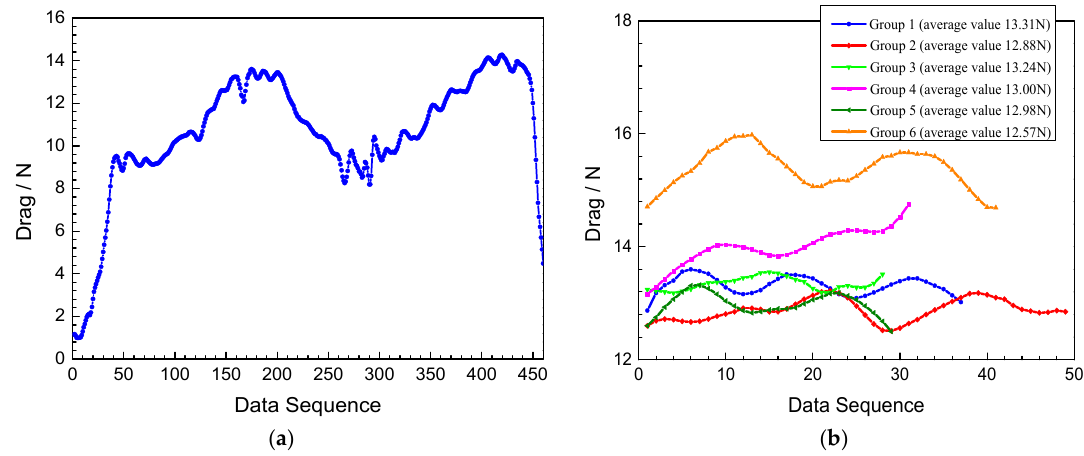
Figure 8. Drag results of the completion string with a packer in the clean deviated section: ( a ) A typical drag curve of the whole moving process; and ( b ) stable sections of six groups of typical drag curves.